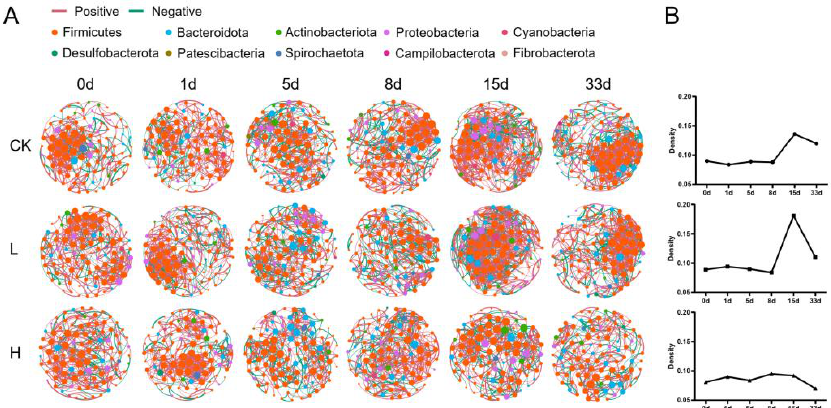
Figure 5. ( A ) Bacterial cooccurrence network depicting Spearman ’ s correlation coefficient based on the levels of bacterial genera (|r| > 0.8, p < 0.05). Nodes represent bacterial genus. The colors indicate the phyla to which they belong, and the sizes indicate the degree of genera, which means the number of connections with other nodes. Edges represent significantly positive (red) or negative (green) correlation, and the widths of edges indicate the Pearson ’ s correlation coefficient (|r|); ( B ) network density in different groups during the whole experiment.